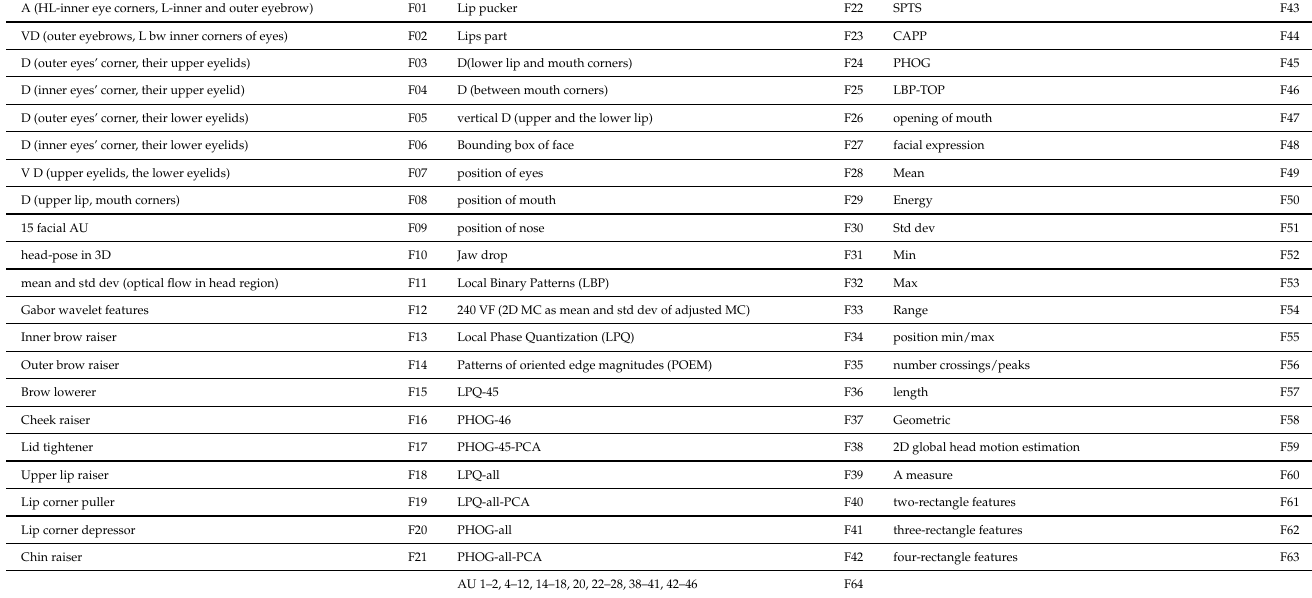
Table 4. Facial expression features.